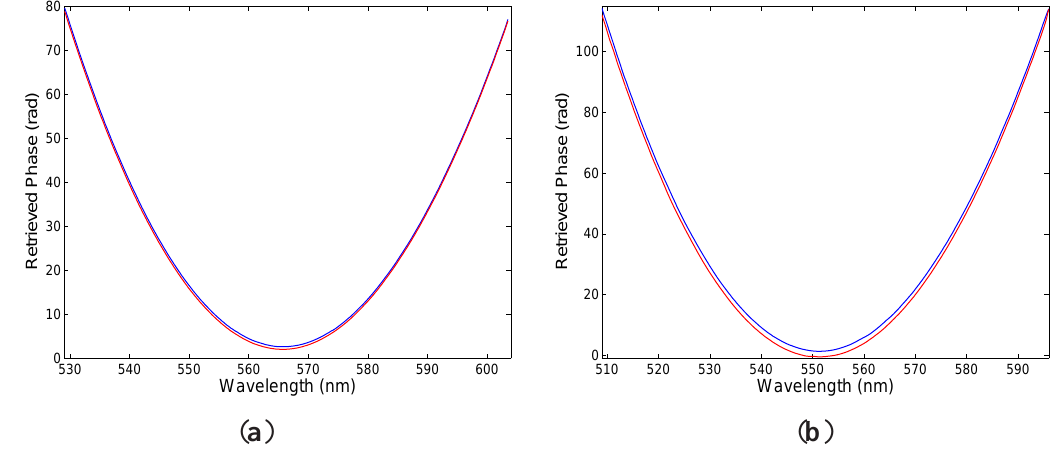
Figure 5. The spectral intermodal sensitivity to strain: x -polarized modes ( a ), y -polarized modes ( b